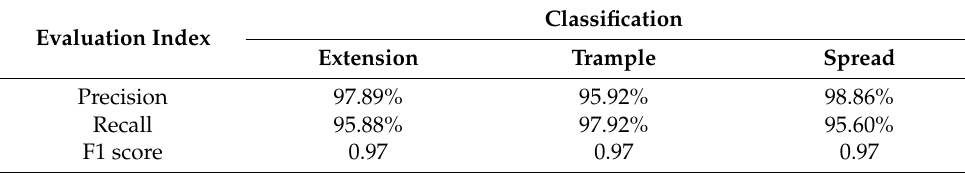
Table 2. The results of precision, recall, and F1 score.